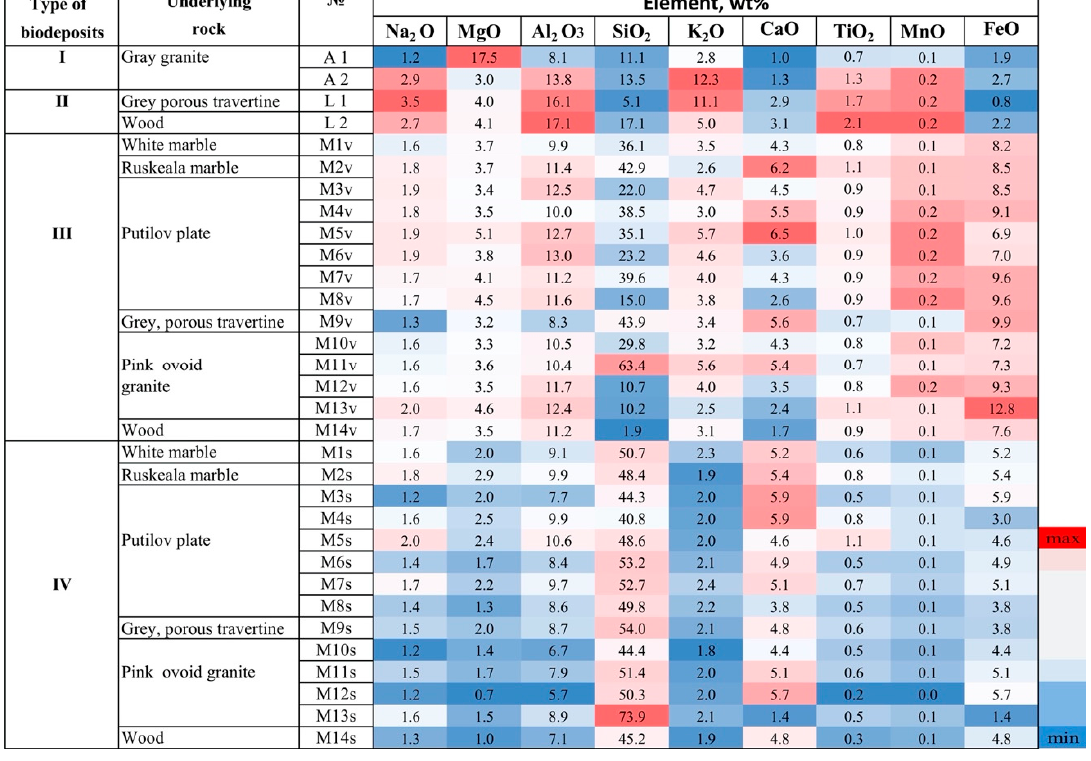
Figure 5. Heat map of the main impurity elements (wt%) in the biodeposits on the surface of the different rocks, (ICP MS analysis data). Table 3. The average content (wt%) of the main impurity elements in the biodeposits. Component